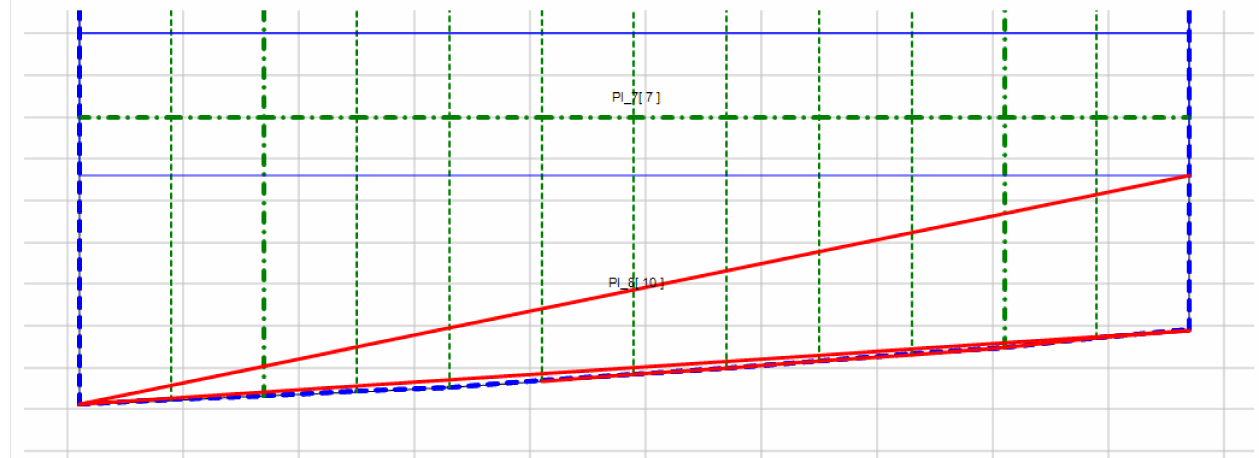
Figure 16. Incorrect formation of plate outlines due to the partial conjunction of two sides of clipping polygon (deck grillage outlines) and two sides of clipped polygon (deck plating outlines). In this Figure green thick dashed line—primary supporting members, thin dashed line—stiffeners, blue dotted line—deck grillage borders, solid blue—plate borders. The red thick line shows the invalid plate border.